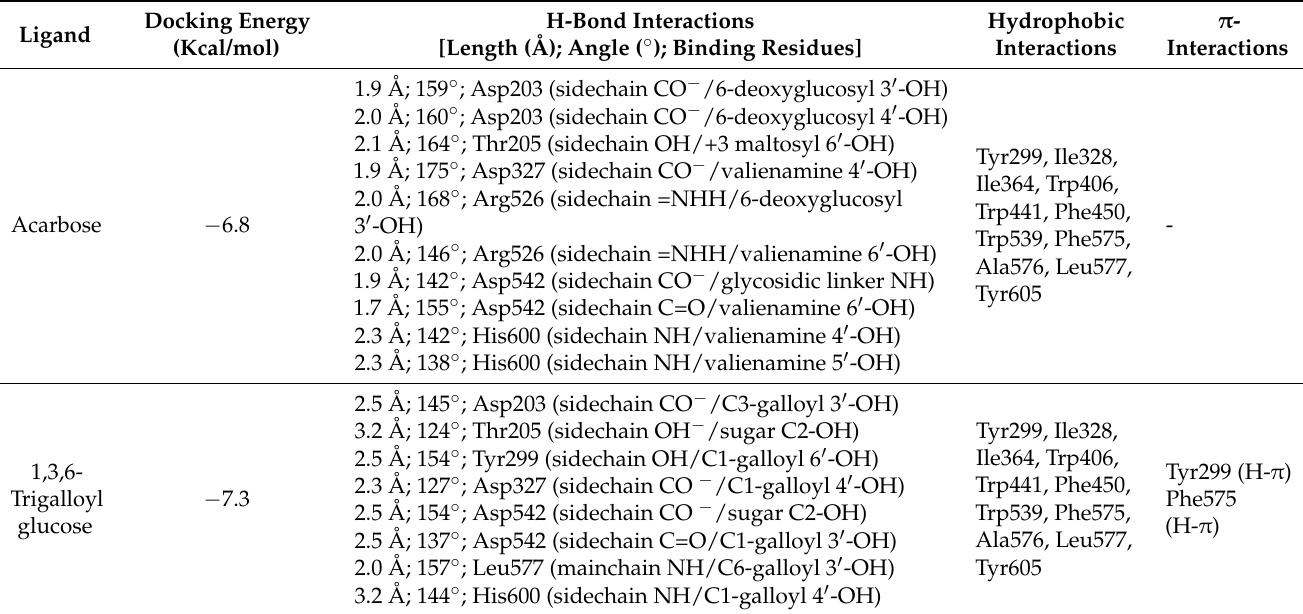
Table 1. Docking energies and descriptions of ligand-hMGAM binding